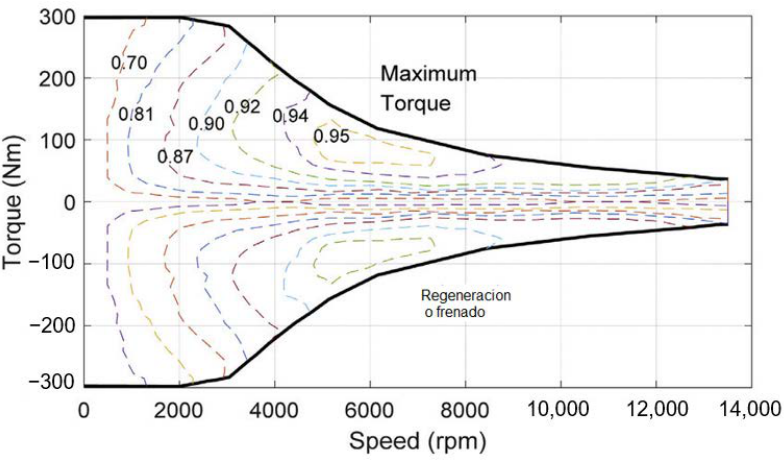
Figure 4. Mirrored efficiency map for regenerative torque.